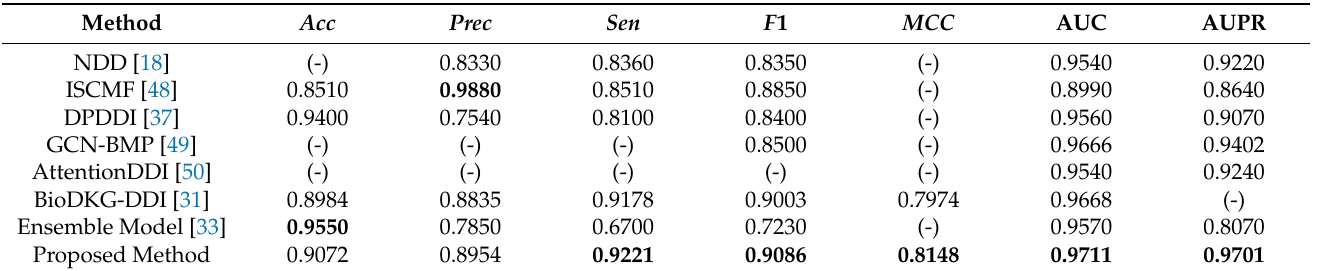
Table 4. Comparison of our proposed method with seven computational